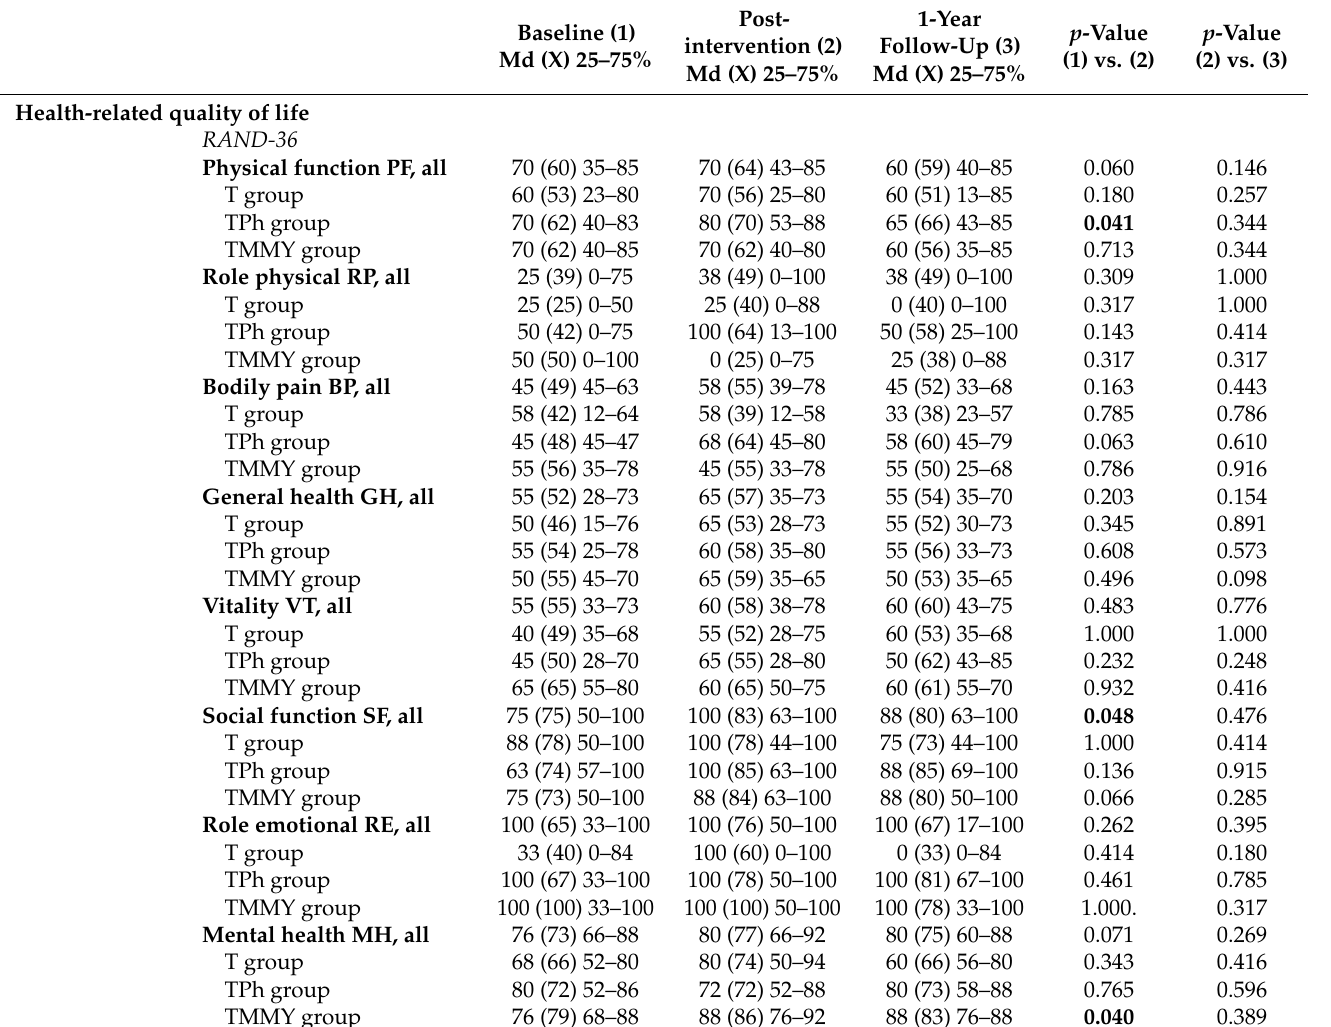
Table 2. Health-related quality of life and the change between the baseline, post-intervention, and 1-year post-intervention follow-up ( RAND-36